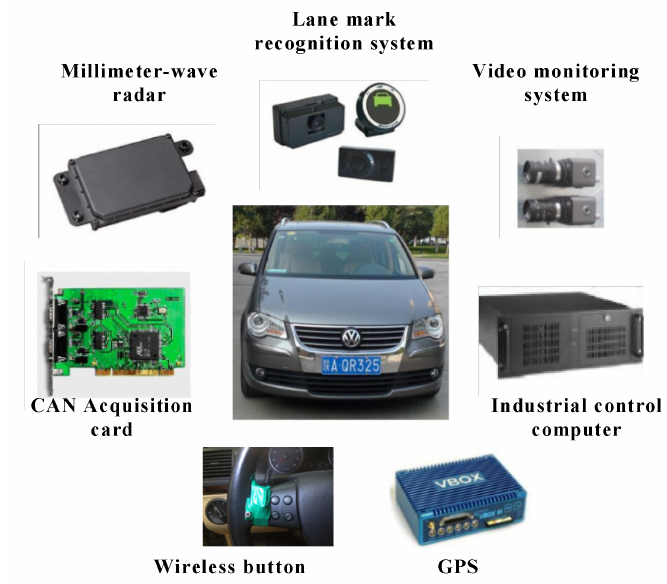
Figure 16. Experimental vehicle used to validate the proposed lane-change decision model in